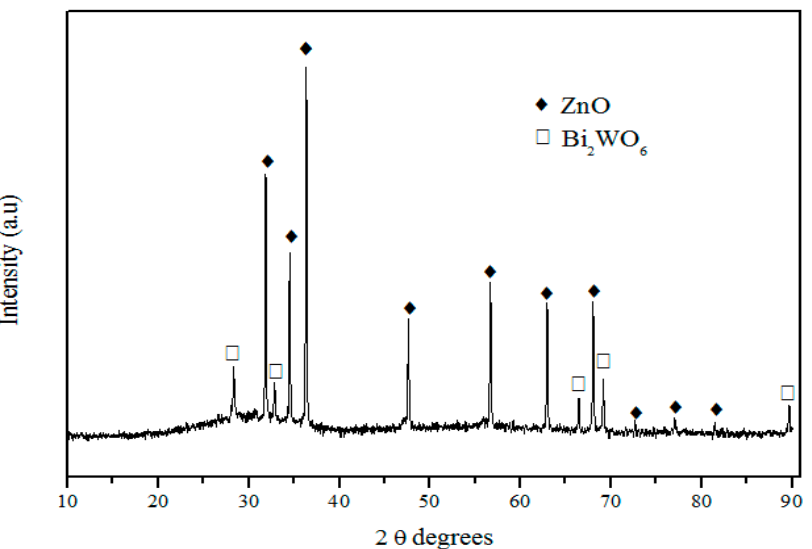
Figure 6. XRD pattern of glass ceramic with nominal composition 58ZnO:4WO 3 :4Bi 2 O 3 :33.4B 2 O 3 heat treated at 500 °C for 15 h.